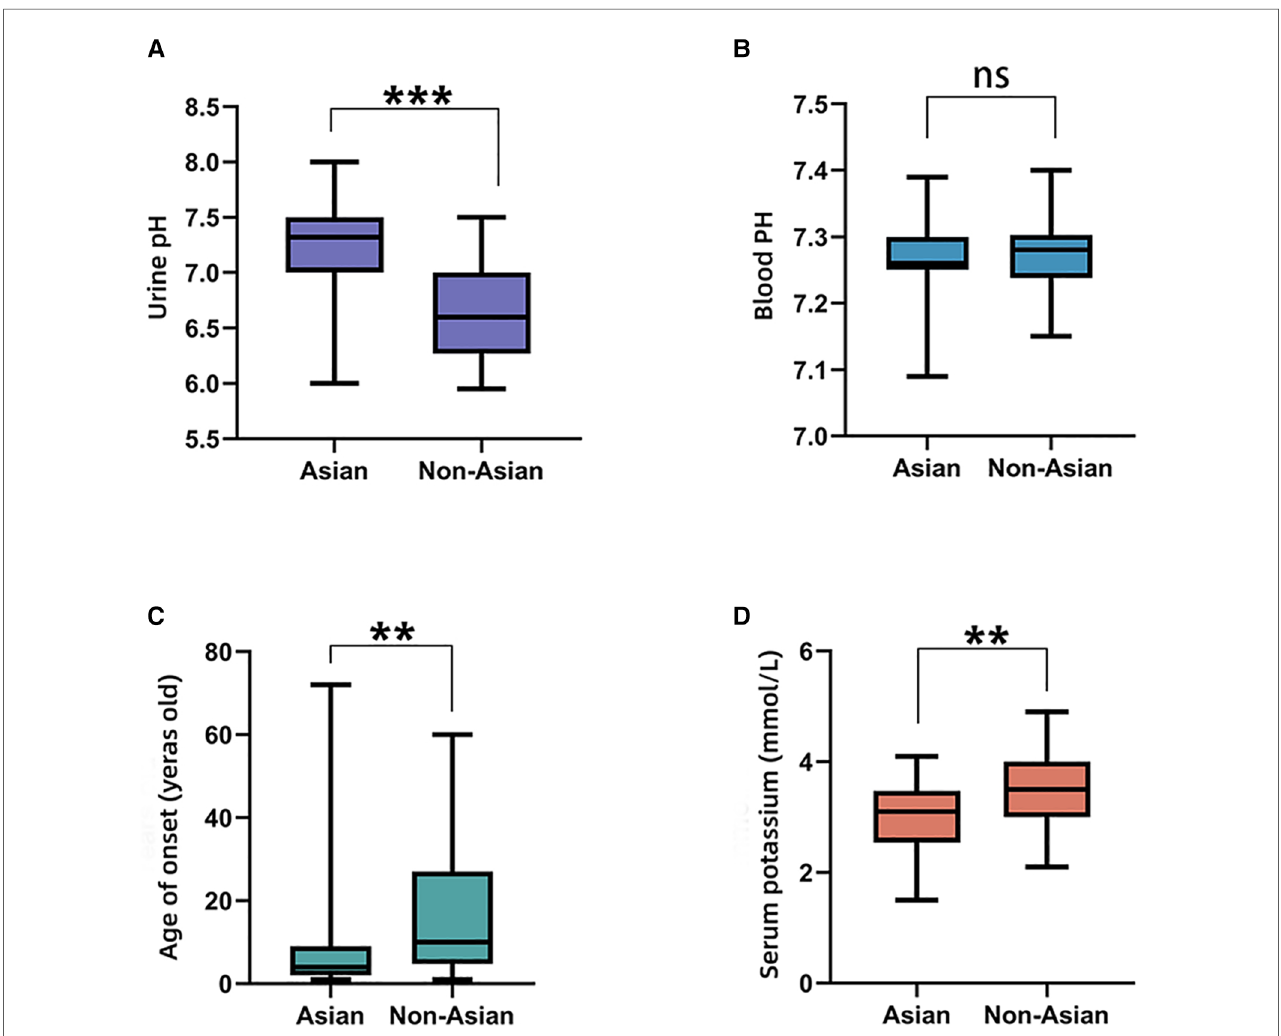
FIGURE 5 The comparisons of biochemical indexes and age of onset between Asian and Non-Asian. ( A ). Urine pH; ( B ). Blood PH; ( C ). Age of onset; ( D ). Serum potassium. * P <0.05; ** P <0.01; *** P <0.001; ns: P